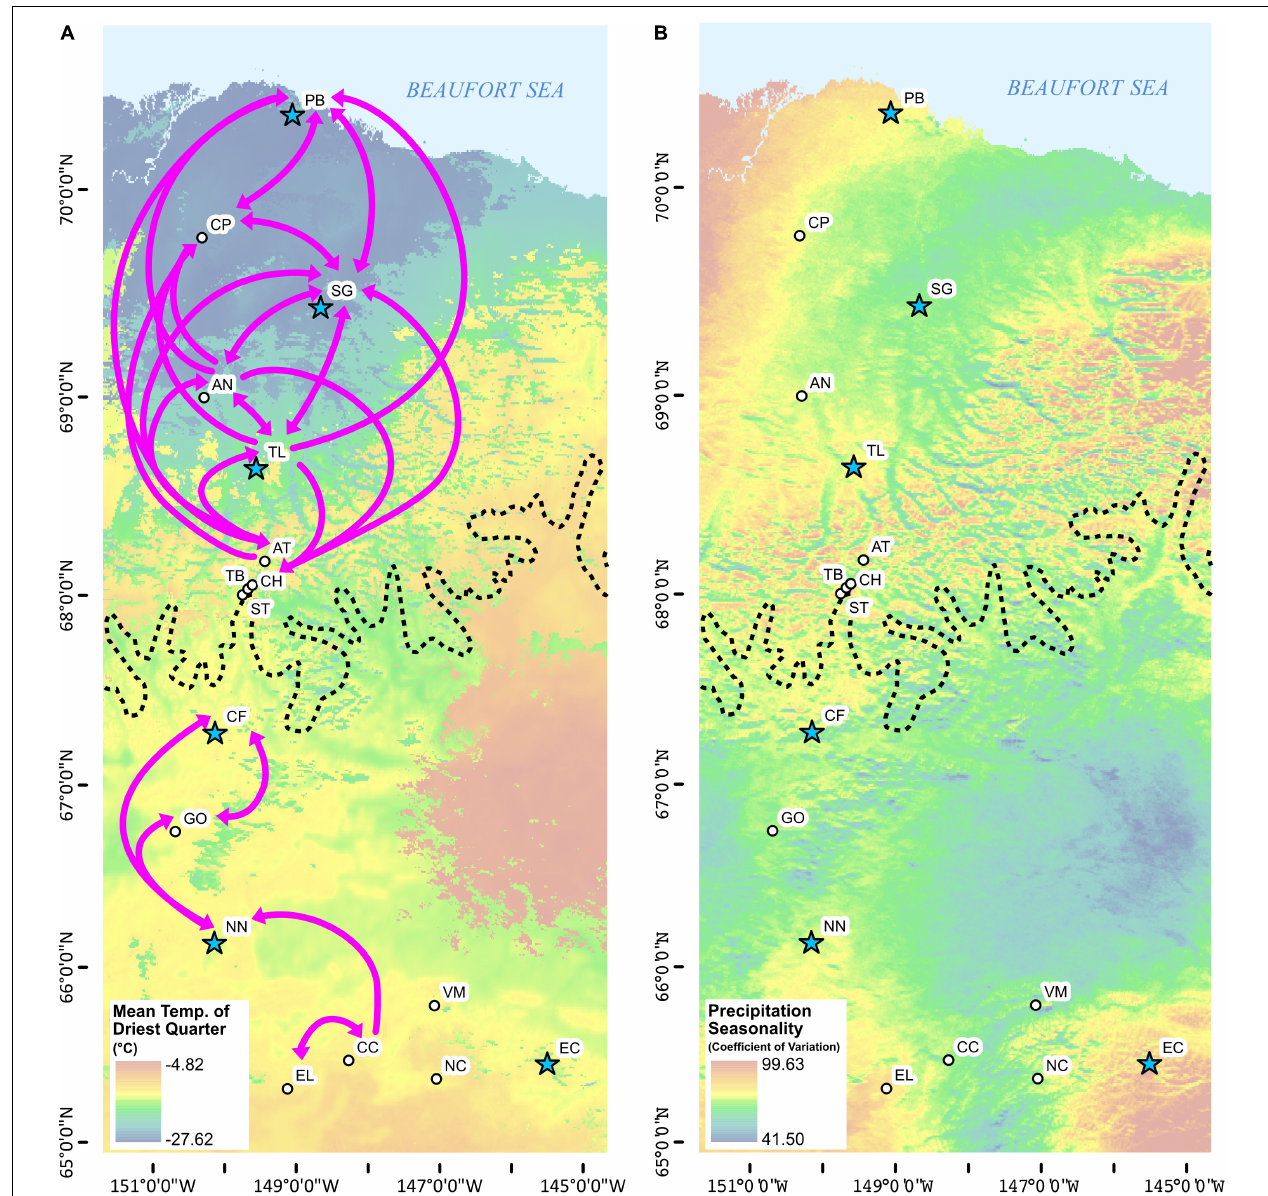
FIGURE 3 | Maps of the study area with (A) mean temperature of the driest quarter (tdq) and (B) precipitation seasonality (prs) WorldClim underlying data layers using ARCMAP v.10.7.1 (ESRI, 2011). Note that divMigrate migration values ≥ 0.80 and direction indicated with arrows are also provided in (A) . Site abbreviations as for Table 1